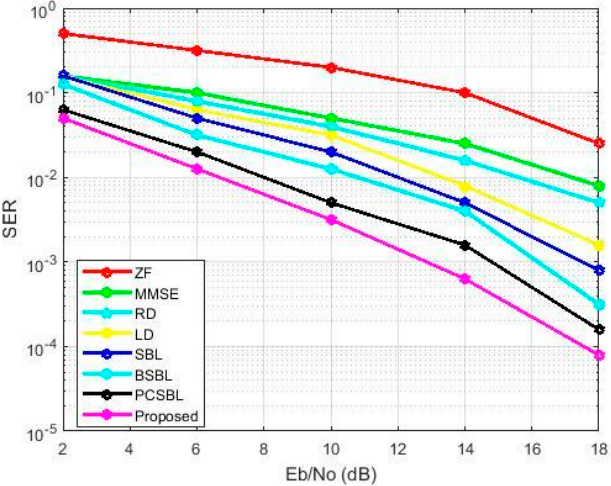
Figure 2. Performance of symbol error rate (SER) vs. signal-to-noise ratio (SNR) (dB) with 20 users.